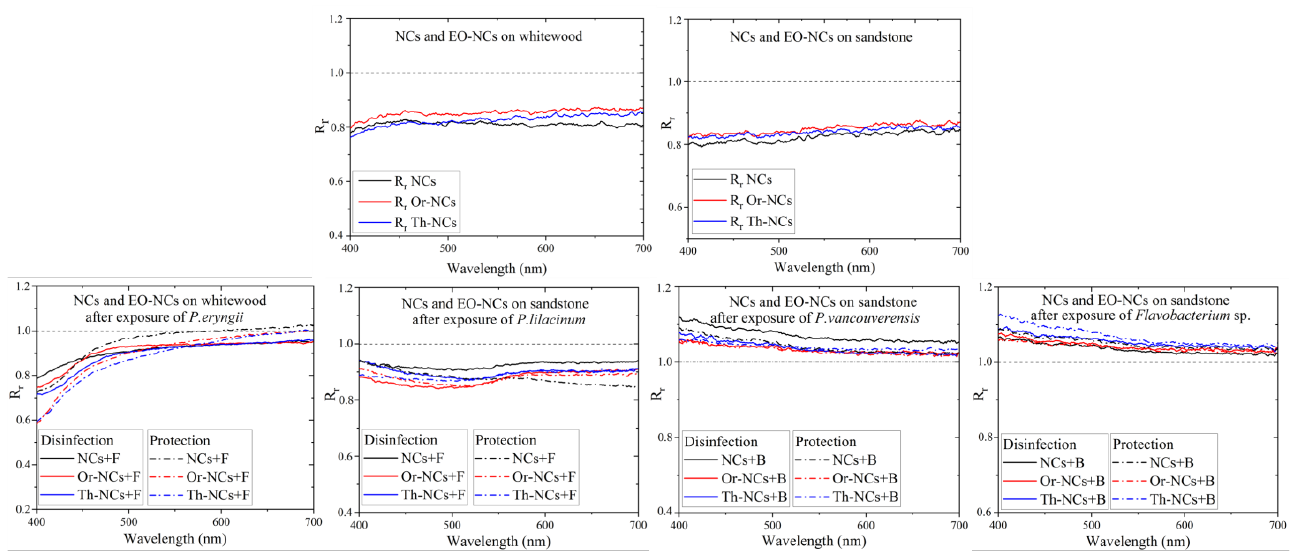
Figure 3. Reflectivity ratio R r as a function of the wavelength for whitewood and sandstone samples before and after the application of microbial cells.